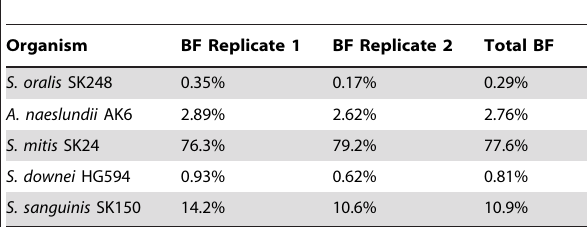
Table 2. Bacterial composition of the model